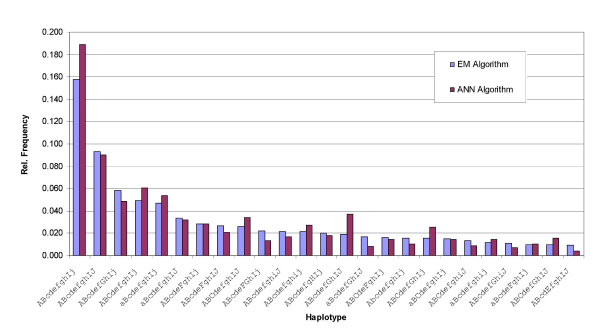
Comparison of algorithms for the 25 most frequently occurring haplotypes.